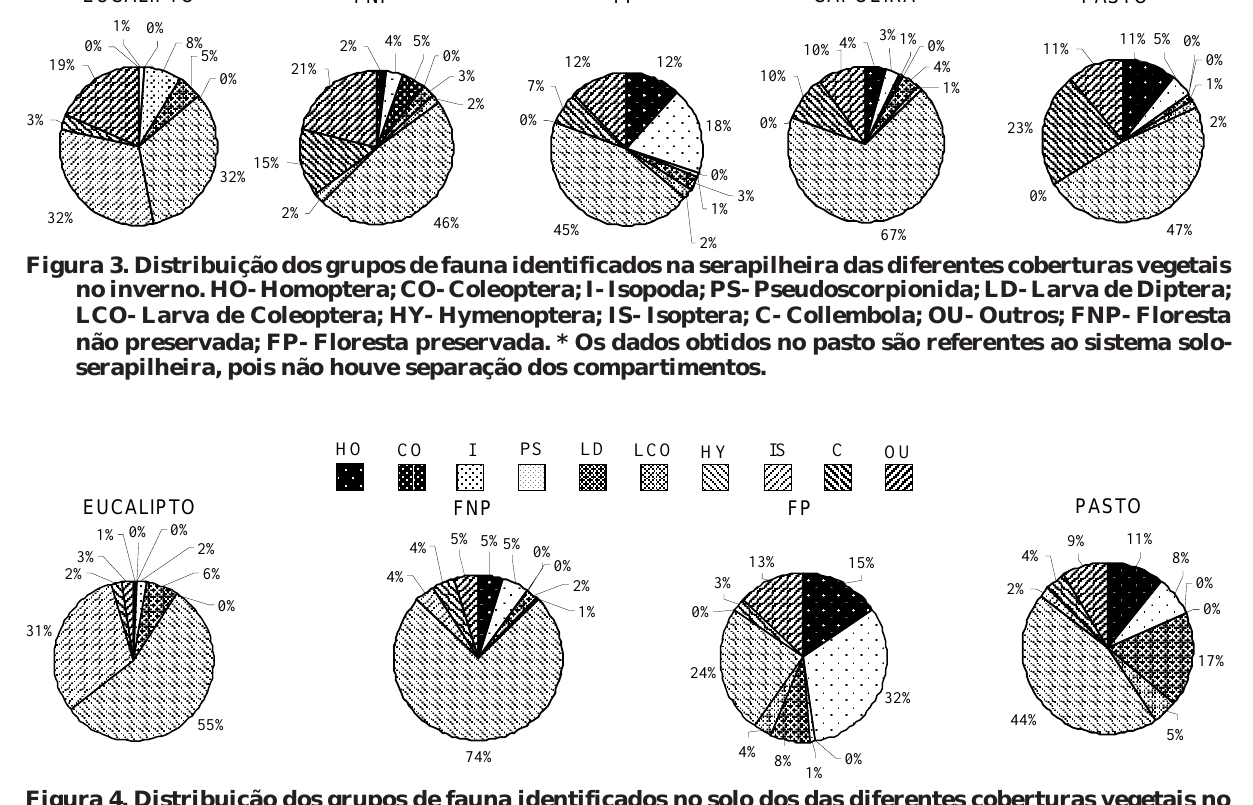
Figura 4. Distribuição dos grupos de fauna identificados no solo dos das diferentes coberturas vegetais no inverno. HO- Homoptera; CO- Coleoptera; I- Isopoda; PS- Pseudoscorpionida; LD- Larva de Diptera; LCO- Larva de Coleoptera; HY- Hymenoptera; IS- Isoptera; C- Collembola; OU-Outros; FNP- Floresta não preservada; FP- Floresta preservada. * Os dados obtidos no pasto são referentes ao sistema solo- serapilheira, pois não houve separação dos